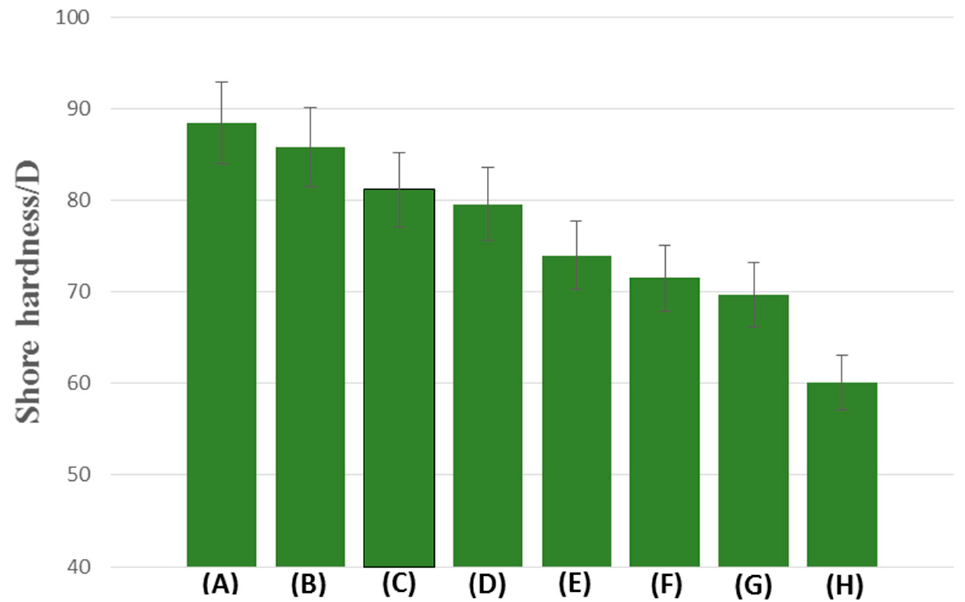
Figure 11. The Shore hardness of: EGDMA + MMA ( A ), EGDMA + MMA + 1% PC (B), EGDMA + MMA + 5% PC ( C ), EGDMA + MMA + 10% PC ( D ), BPA.GDA + MMA ( E ), BPA.GDA + MMA + 1% PC ( F ), BPA.GDA + MMA + 5% PC ( G ) and BPA.GDA + MMA + 10% PC ( H ).